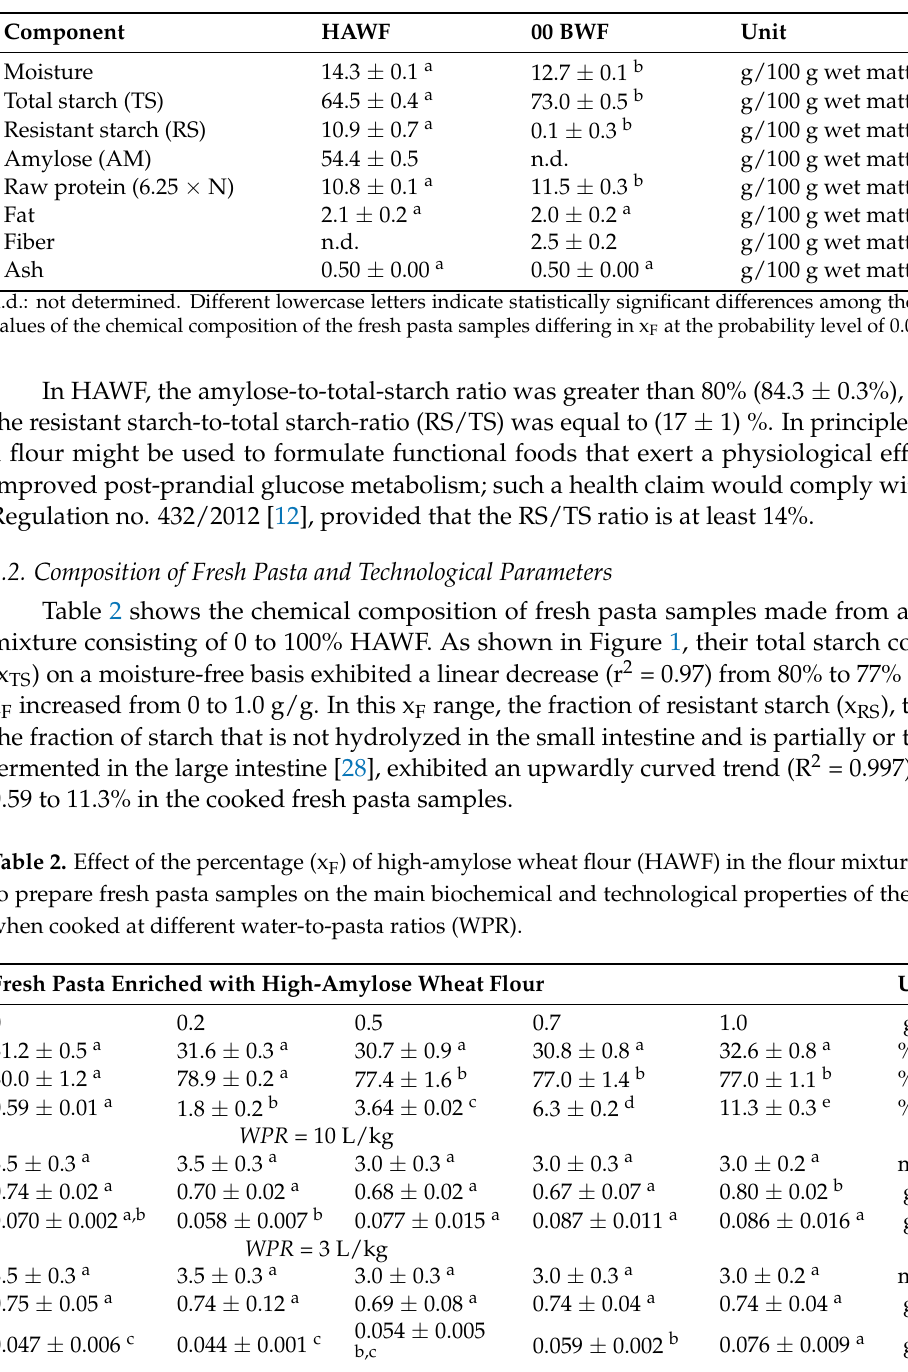
Table 1. Chemical compositions of the high-amylose (HAWF) and type 00 (00 BWF) common wheat flours used in this work.